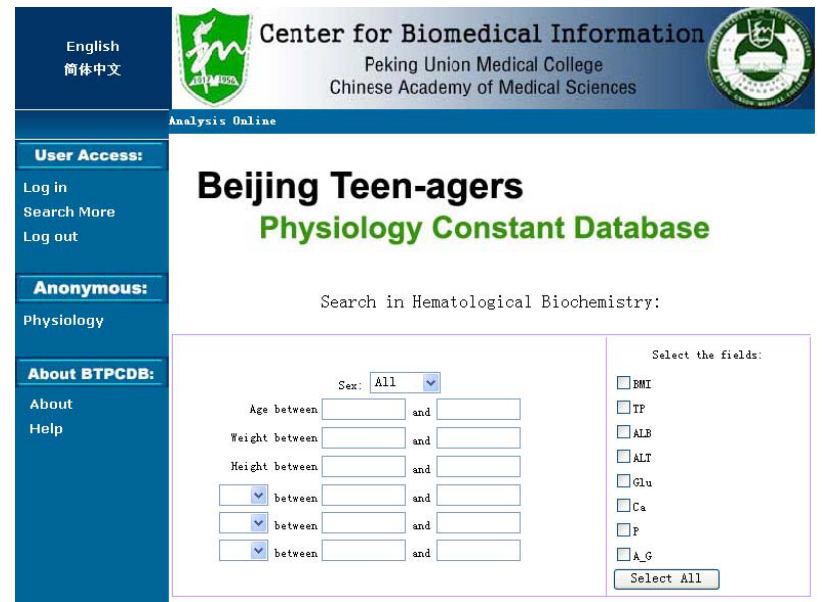
FIGURE 1 . Hematological biochemistry query interface.